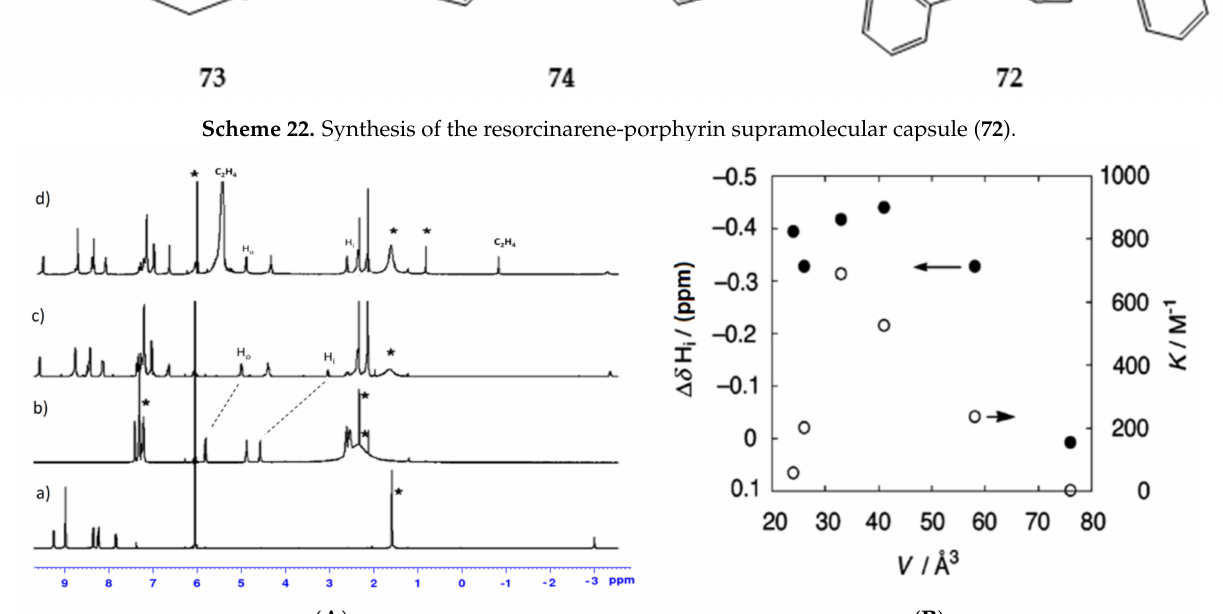
Figure 14. ( A ) 1 H-NMR spectrum of porphyrin 73 ( a ), resorcinarene 74 ( b ), capsule 72 ( c ), and its complex(with ethylene ( d ) at 298 K; ( B ) difference in the chemical shifts, ∆ δ H i ( · ), and binding constants, K ( O ), depending on the substrate size. ∆ δ H i = (H i for the incapsulated substrate)-(Hi for the unbound substrate)